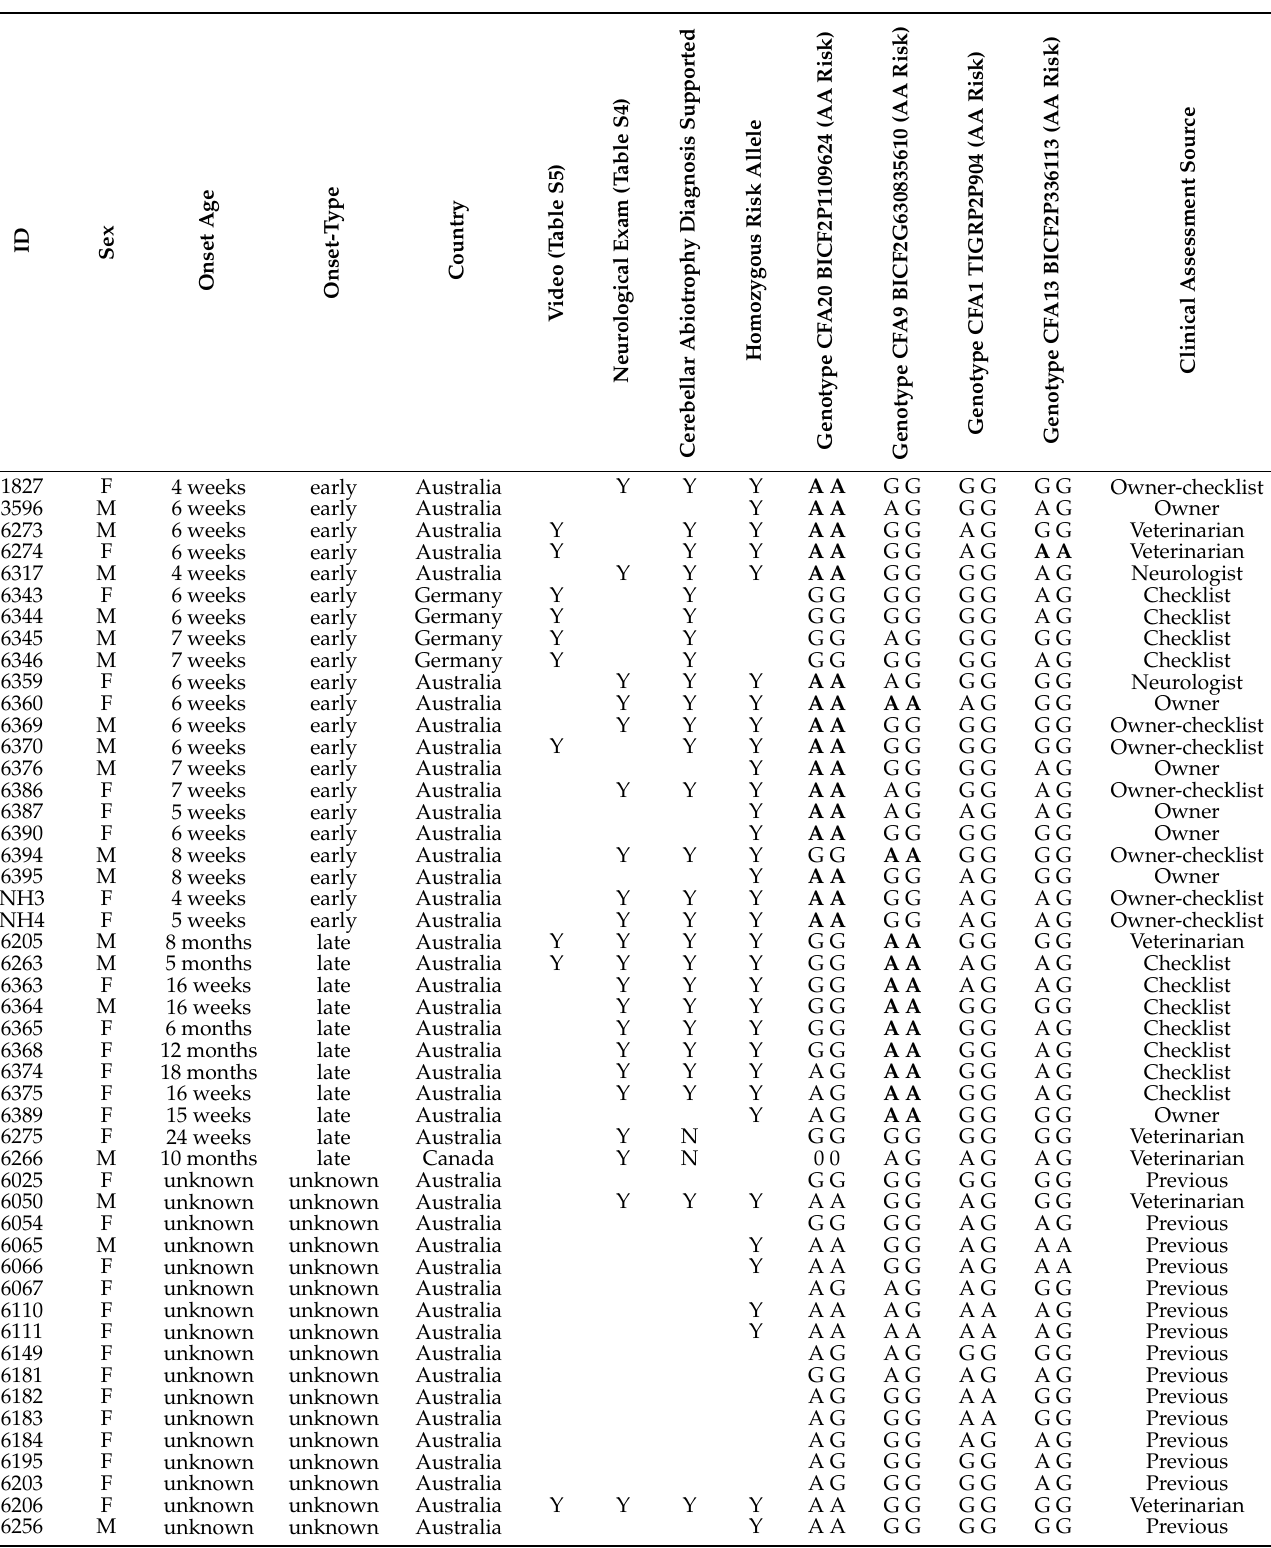
Table 1. Characteristics of 49 case samples including their genotypes at risk loci identified by GWAS. Risk genotypes for each locus shown in bold